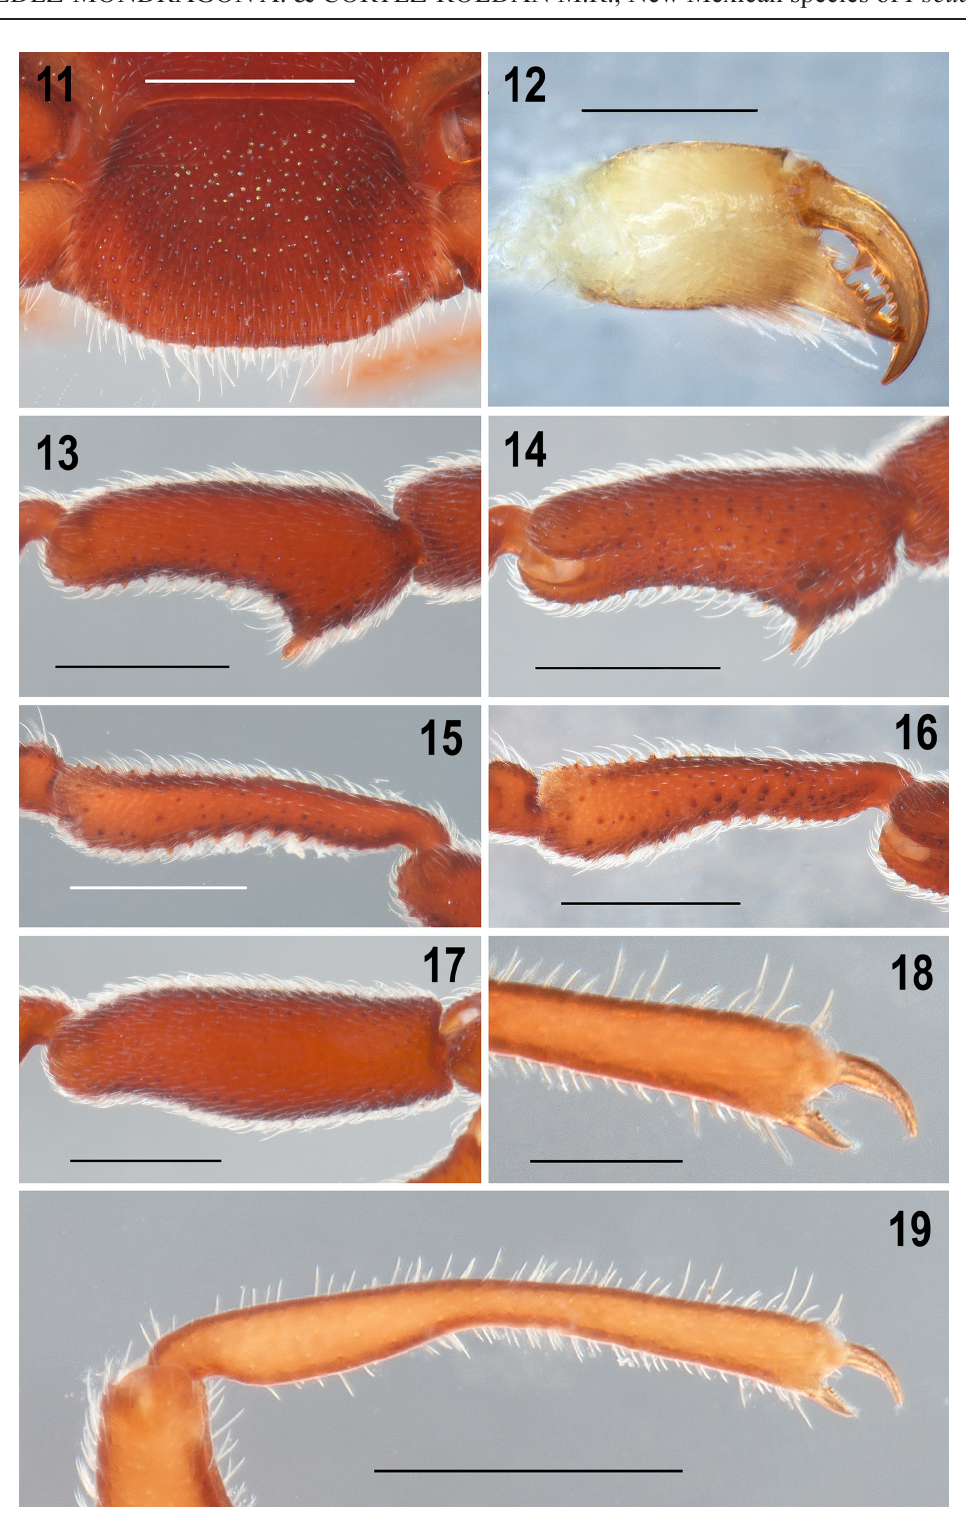
Figs 11–19. Pseudocellus giribeti sp. nov. Holotype, ♂ (MCZ 80010). 11 . Cucullus, dorsal view. 12 . Left chelicera, dorsal view. 13–14 . Right tibia II, prolateral and proventral views. 15–16 . Right metatarsus II, prolateral and proventral views. 17 . Right femur II, prolateral view. 18 . Detail of the movable and fixed claws of the right pedipalp, retrolateral view. 19 . Right pedipalp tibia, retrolateral view. Scale bars: 11, 13–17, 19 = 0.5 mm; 12 = 0.2 mm; 18 = 0.1